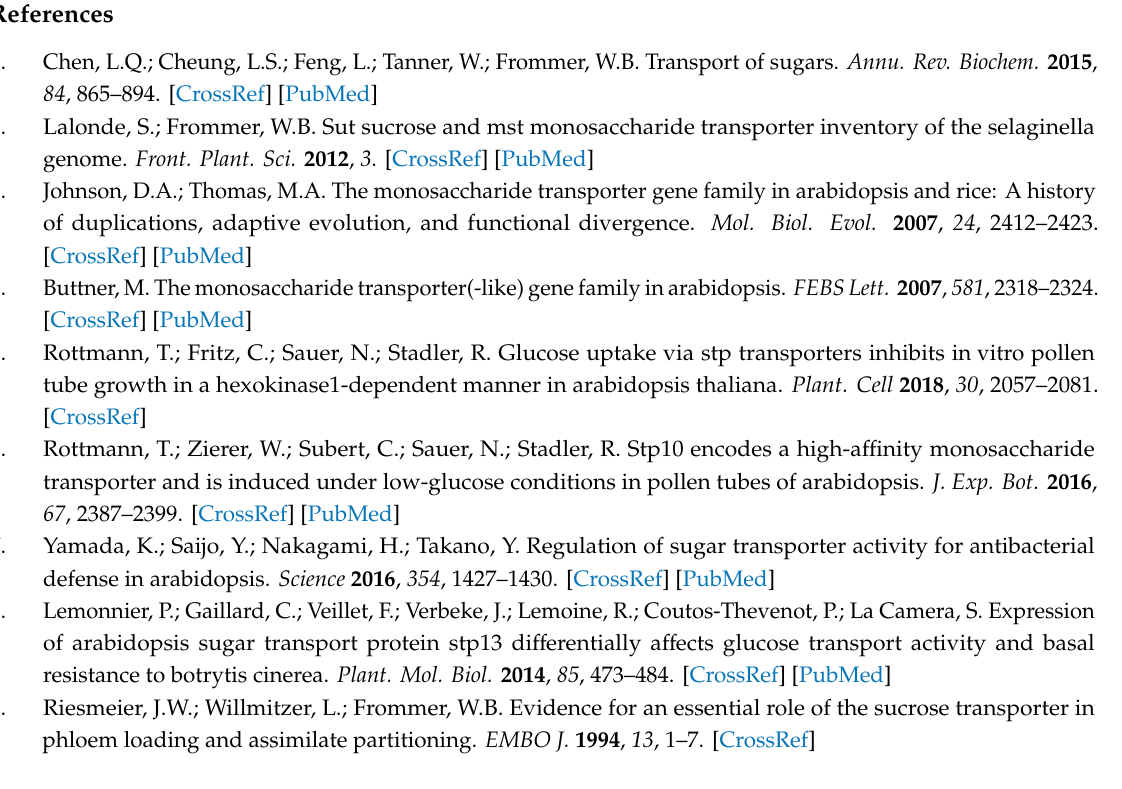
Supplemental Figure S1: Protein sequence alignment of the seven JsSWEETs and the Arabidopsis and rice homologs, Supplemental Table S1: List of Primers used for RACE cloning, Supplemental Table S2: List of Primers used for full length PCR amplification, Supplemental Table S3: List of Primers used for RT-qPCR. Supplemental Table S4: Percent Identities of JsSWEETs with homolgous from Arabidopsis and